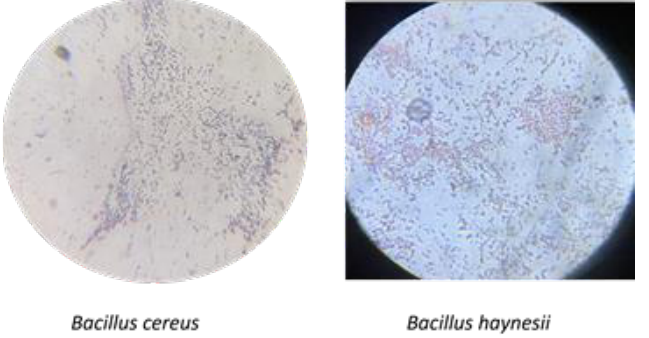
Figure 1. Slides observed under light microscope (100x oil immersion resolution) of two strains after Gram staining. Gram